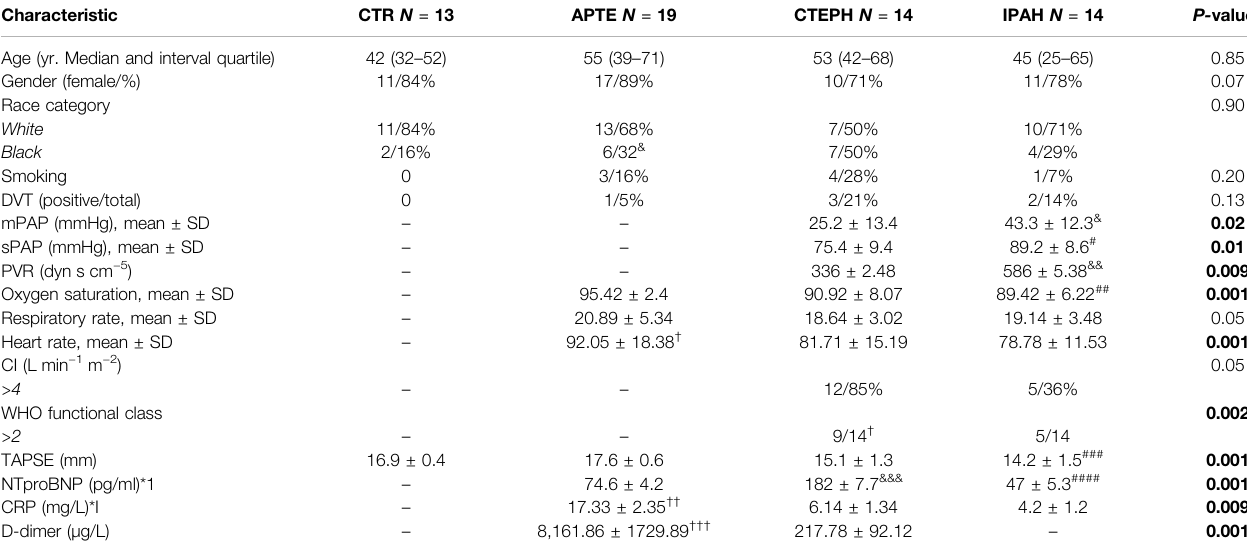
TABLE1 | Baseline and clinical characteristics of the NGS cohort and healthy subjects.